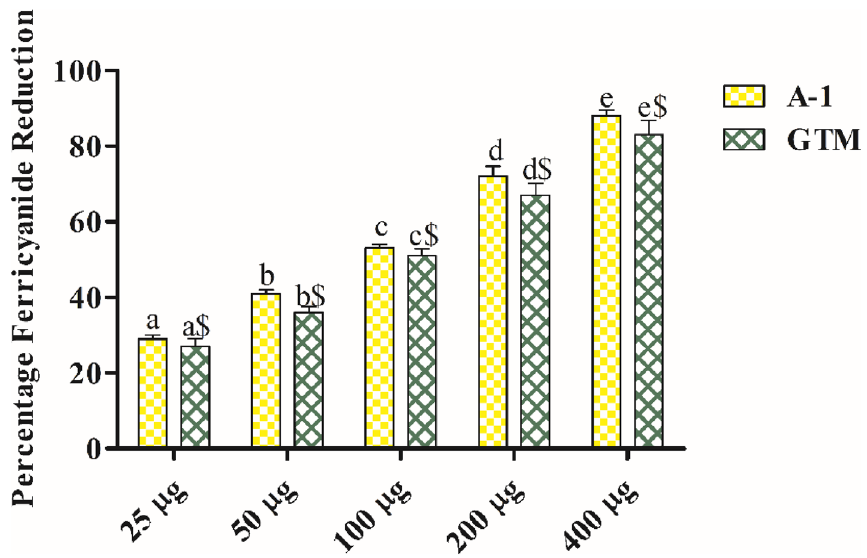
Figure 3. Reducing power assay of isolated compound and GTM. Data is presented as mean ± SEM. GTM G. tiliaefolia methanol extract. Data sets with different alphabets differ significantly (p < 0.05) from each